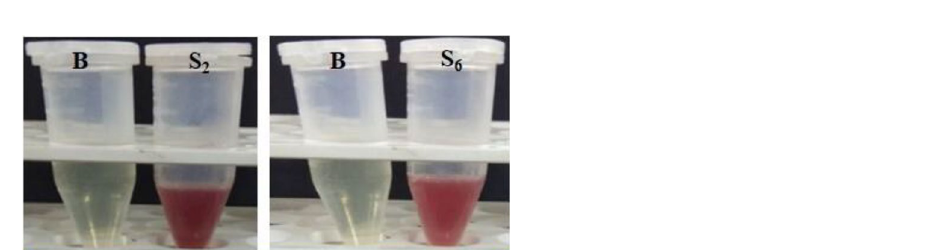
Figure 6. Siderophore produced by isolate S 2 and S 6 .